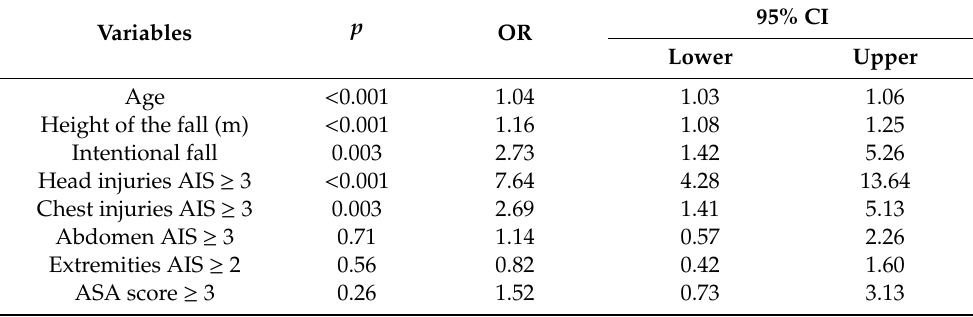
Table 3. Multivariate analysis—general population.